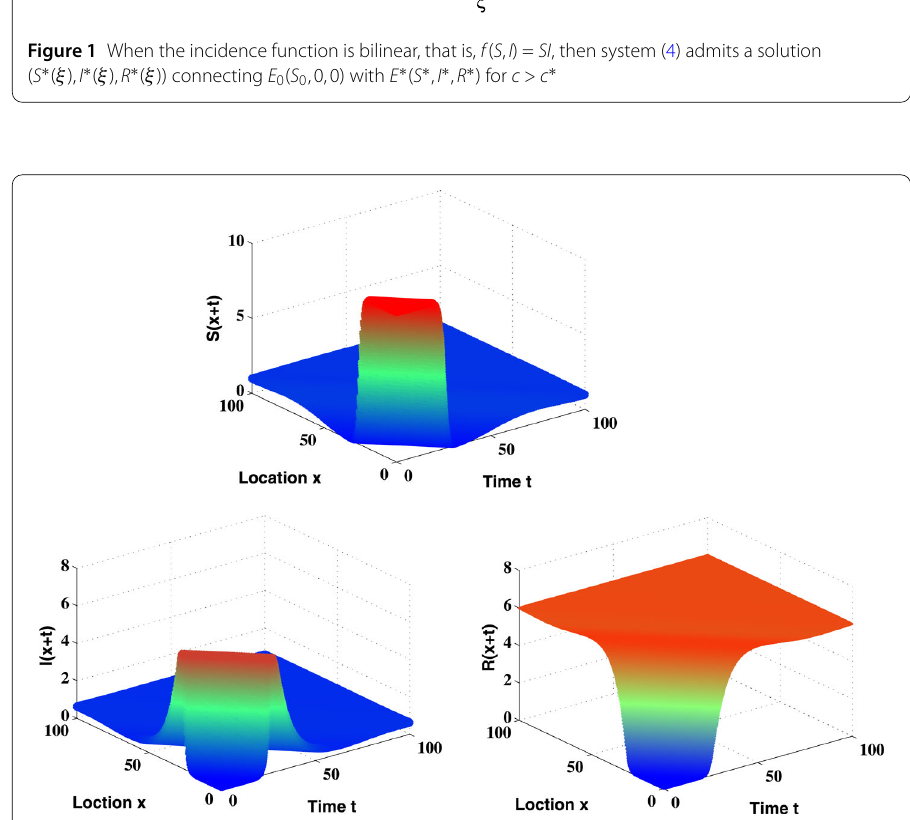
Figure 2 The traveling solution ( S ( x + t ), I ( x + t ), R ( x + t )) is observed for system (4), where the initial ( S (0), I (0), R (0)) = (10,0.00000001,0)